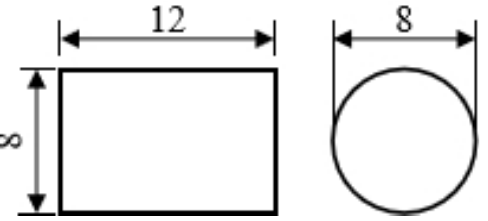
Figure 1. Thermal compression sample geometry (lengths in mm).